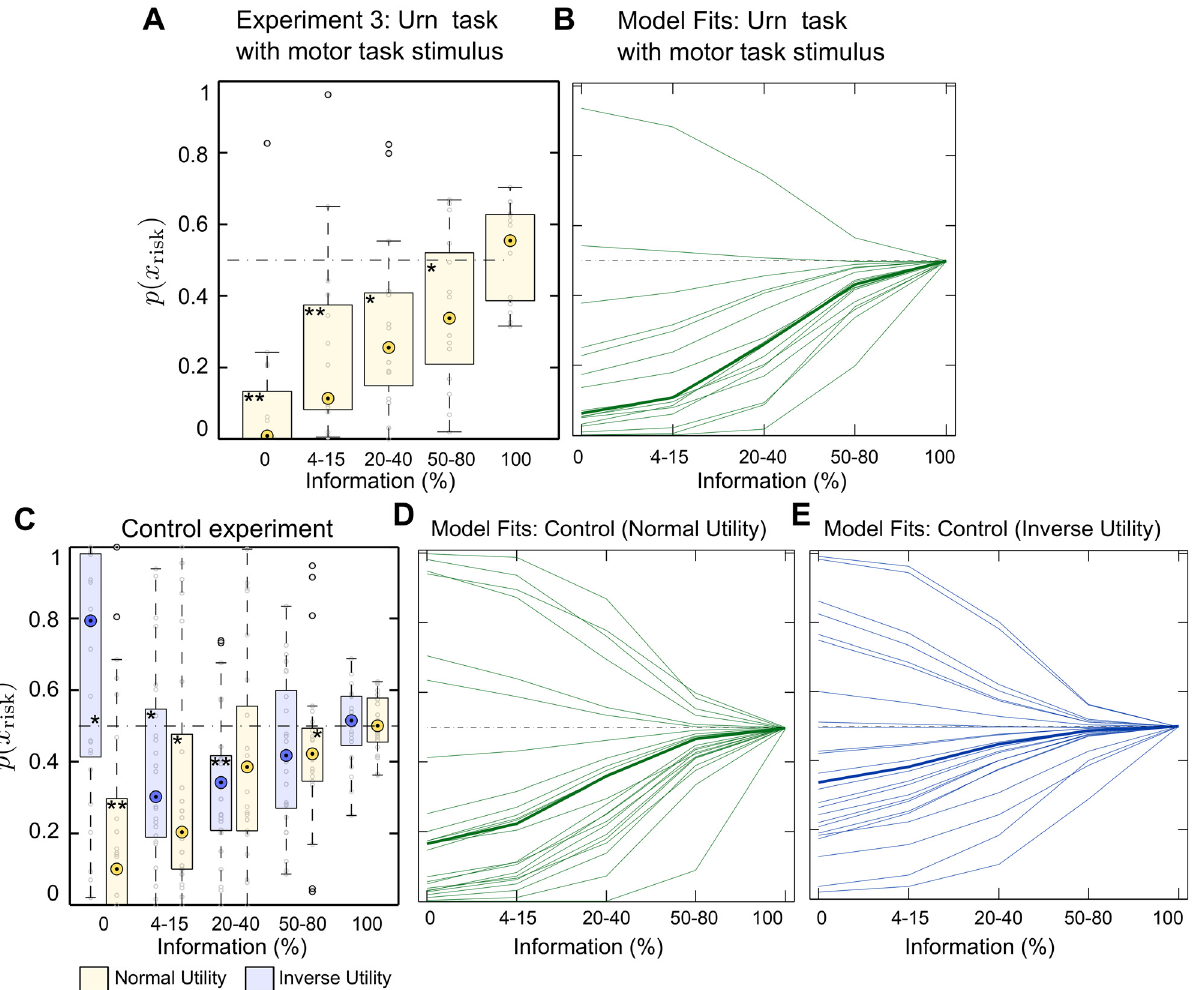
Fig 4. Experiment 2. Panel A shows Experiment 3 choice data where subjects are ambiguity-seeking as in the motor task and not ambiguity-averse as in the urn task — compare Fig 3. Panel C shows experimental choice data of the control experiment where subjects are ambiguity-seeking in most trials independent of the utility function — normal utility condition as in Experiment 3 or inverse utility condition. Probability values above the dashed line predicted by expected utility imply that subjects prefer the risky choice (ambiguity aversion), probability values below the dashed line imply that subjects prefer the ambiguous choice (ambiguity preference). The normal utility condition is colored in light orange, the inverse utility condition is colored in light blue. The boxes are centered around the median across subjects and the edges of the box are the 25th and 75th percentiles. Asterisks denote significant deviation from the expected utility prediction: one asterisk signifies p < 0.05, two asterisks signify p < 0.01. Panels B , D and E show the corresponding model fits. The thin lines represent individual subjects ’ choice probabilities according to Eq (4), the thick lines indicate the group mean. Note in panel E , how the our information- theoretic model (and the expected utility model) is unable to produce simultaneously ambiguity aversion in the zero information limit and ambiguity seeking behavior in the other information